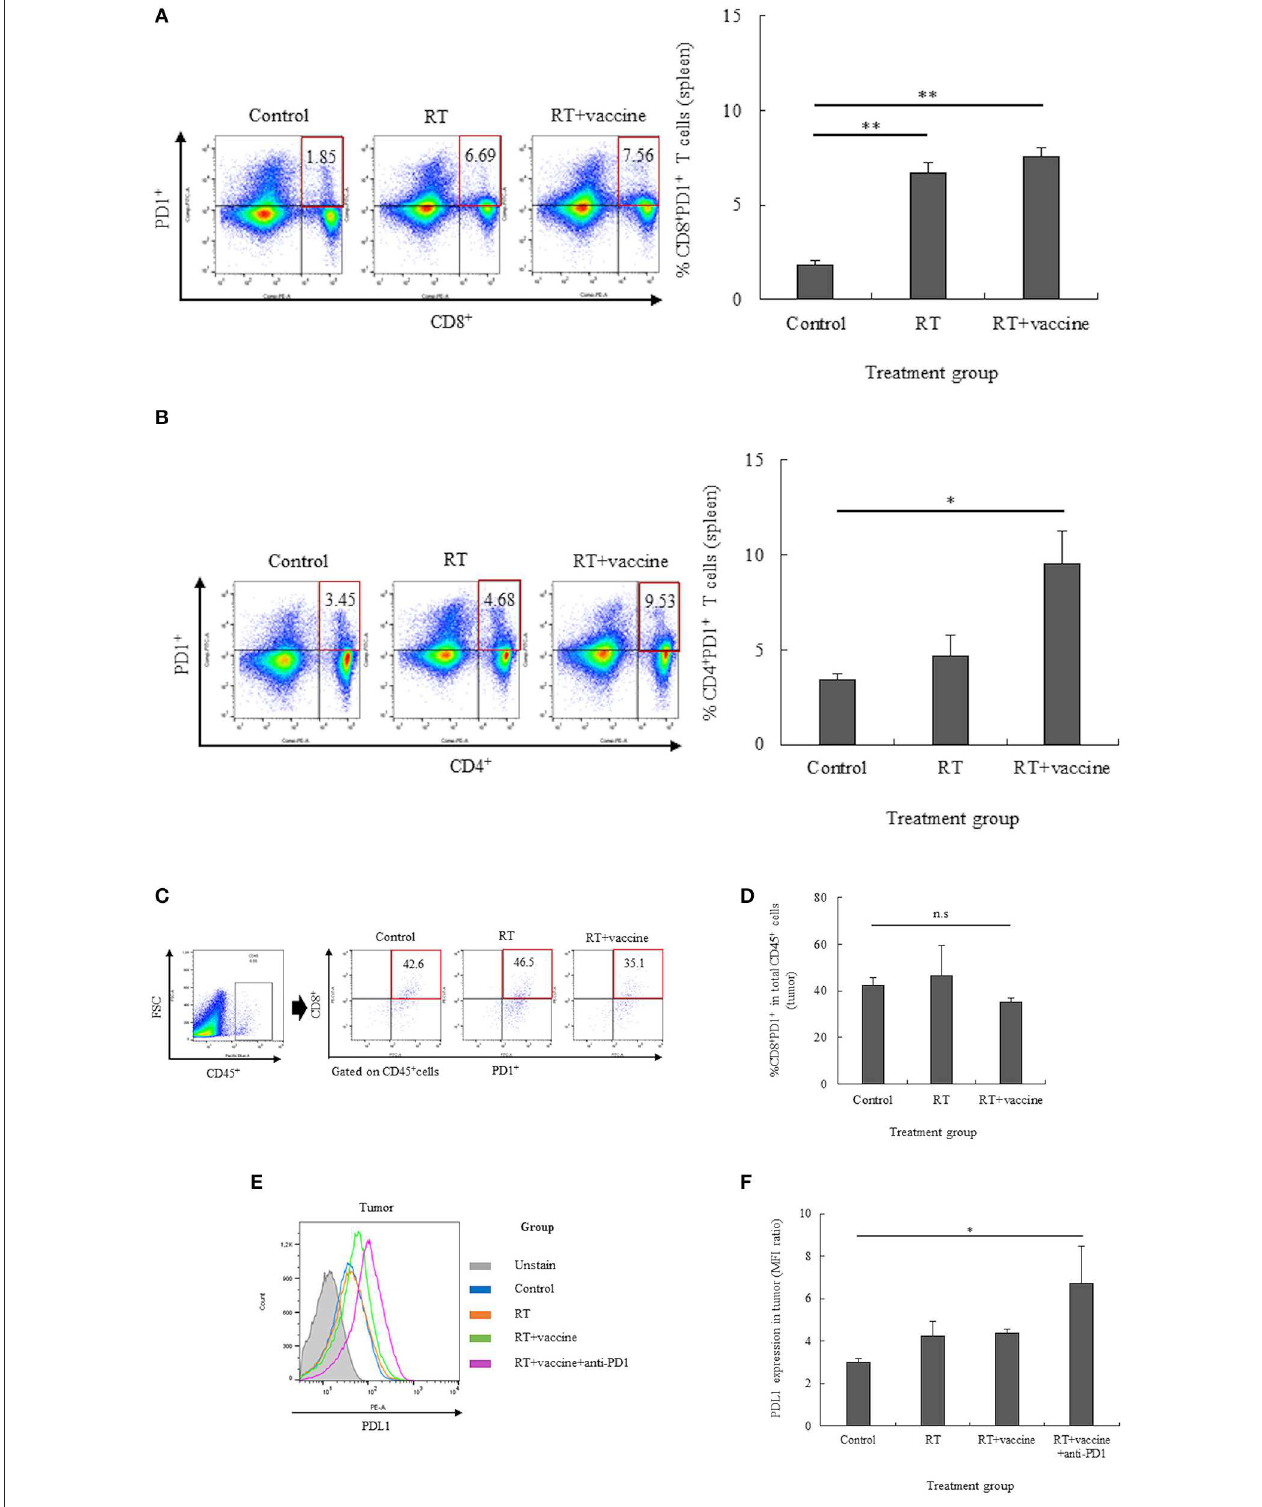
FIGURE 3 | The expression of PD1 on T lymphocytes in the spleen and tumor and that of PDL1 on the tumor were estimated by flow cytometry. The expression of PD1 on the T lymphocyte population was estimated, and percentages of CD8 + PD1 + T cells or CD4 + PD1 + T cells in the spleen and CD8 + PD1 + T cells in the tumor were determined (A–D) . The expression of PDL1 in the tumor was also clarified (E,F) . Data are summarized by bar charts as the mean ± standard deviation (SD). All data are represented as the mean of two independent experiments. Control, no treatment group; RT, radiation therapy; vaccine, branched multipeptide plus PADRE and poly-ICLC; * p < 0.05; ** p < 0.01; and n.s., no significant difference.